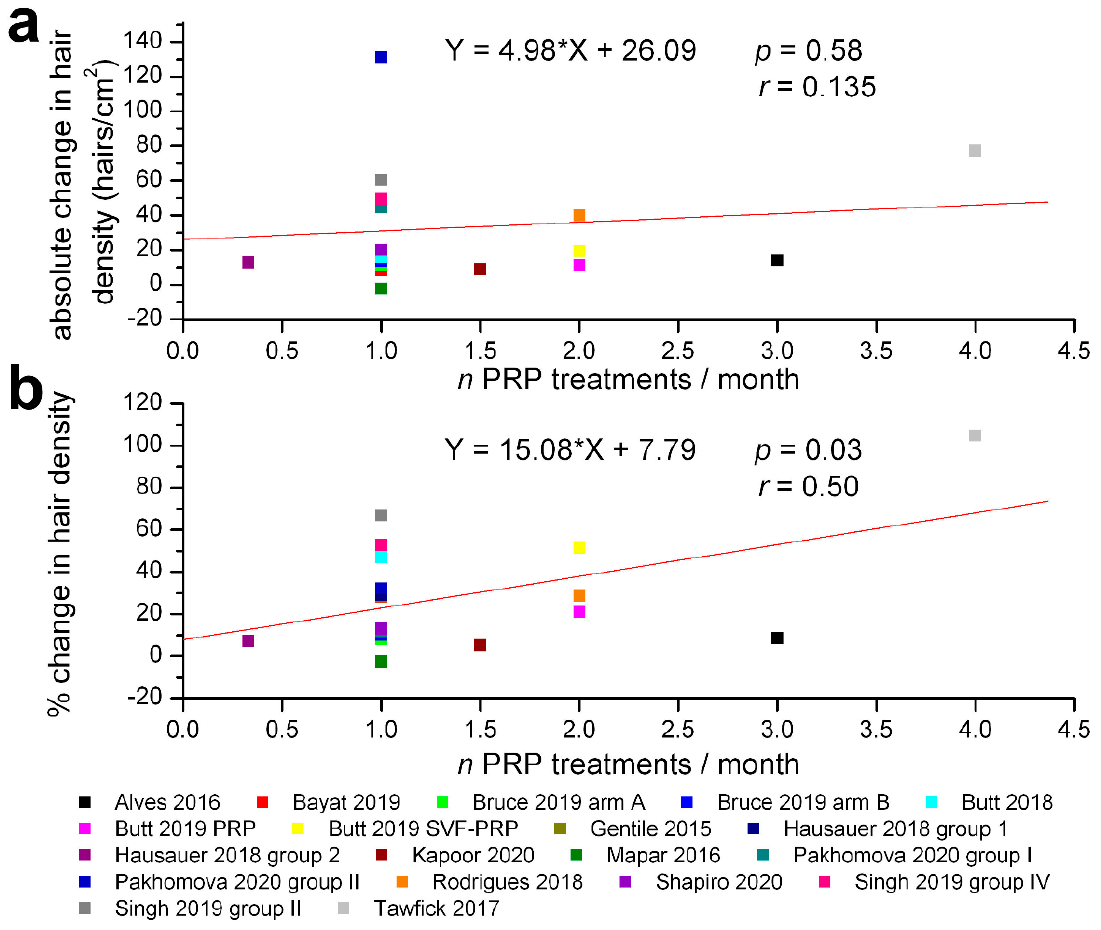
Figure 5. Correlations between the frequency of PRP treatments and absolute or percentage change in hair density within the clinical trials selected for meta-analysis. ( a ) lack of significant correlation of absolute changes in hair density (hairs/cm 2 ) at the end of evaluation period. ( b ) significant correlation with percentage changes in hair density relative to initial values (same legend for both graphs). The regression lines are plotted in red, and the corresponding equations, values of correlation coefficients r and their probabilities p are marked on each graph.